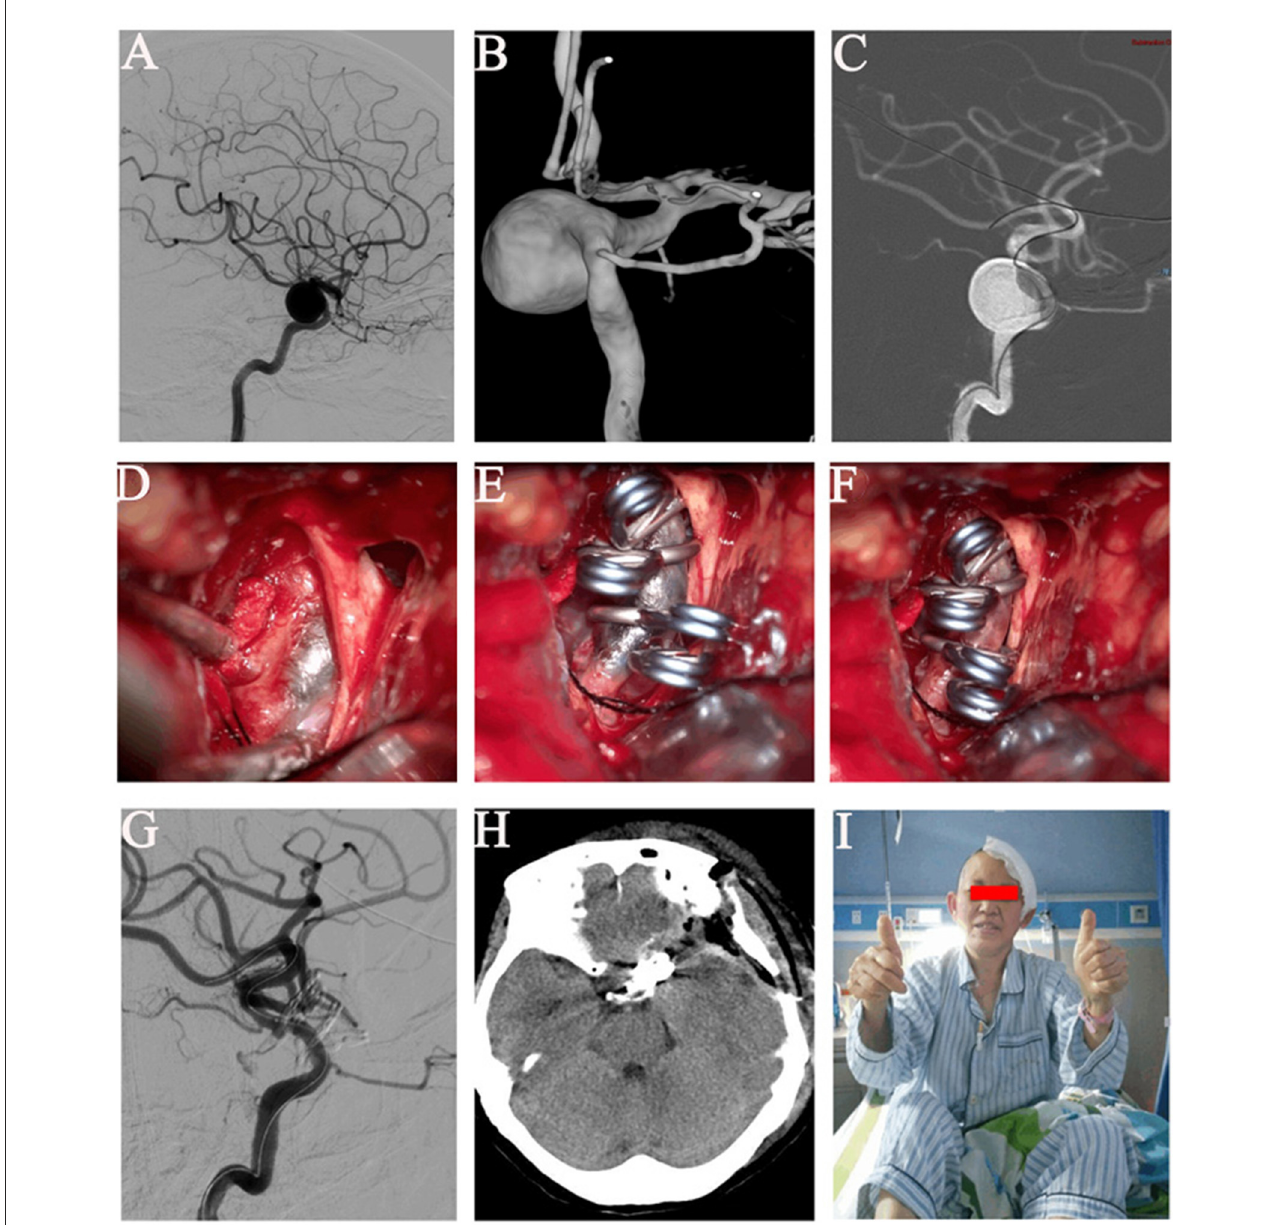
FIGURE2 Images of a left giant paraclinoid aneurysm. (A) Angiography of a left wide-necked giant paraclinoid aneurysm of the internal carotid artery. (B) Three-dimensional digital subtraction angiography of the left wide-necked giant paraclinoid aneurysm. (C) The balloon was successfully inserted into the position of the neck of the aneurysm. (D) The balloon was dilated with methylene blue and could be clearly seen under the microscope, and the balloon adhered well to the wall. The blood supply of the aneurysm was completely blocked. (E) When the neck was blocked, the aneurysm was successfully clipped and the parent artery was reconstructed. (F) The balloon was withdrawn after the aneurysm had been satisfactorily clipped. (G) Digital subtraction angiography of the left internal carotid artery after successful clip occlusion showed no parent artery stenosis, no residual aneurysm, and a well-perfused distal vessel. (H) Head computed tomography on postoperative day 2. (I) This patient gained full consciousness without a neurological